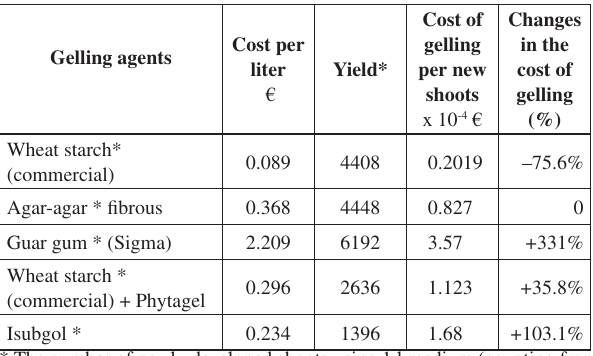
Table 2. Comparison of the economy of media solidifi ed with different gelling agents Cost per Gelling agents